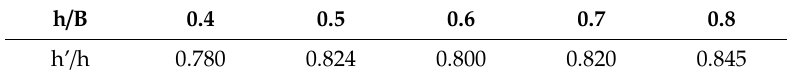
Table 7. Ratio of the initial fluid height to the minimum sloshing height according to h / B.